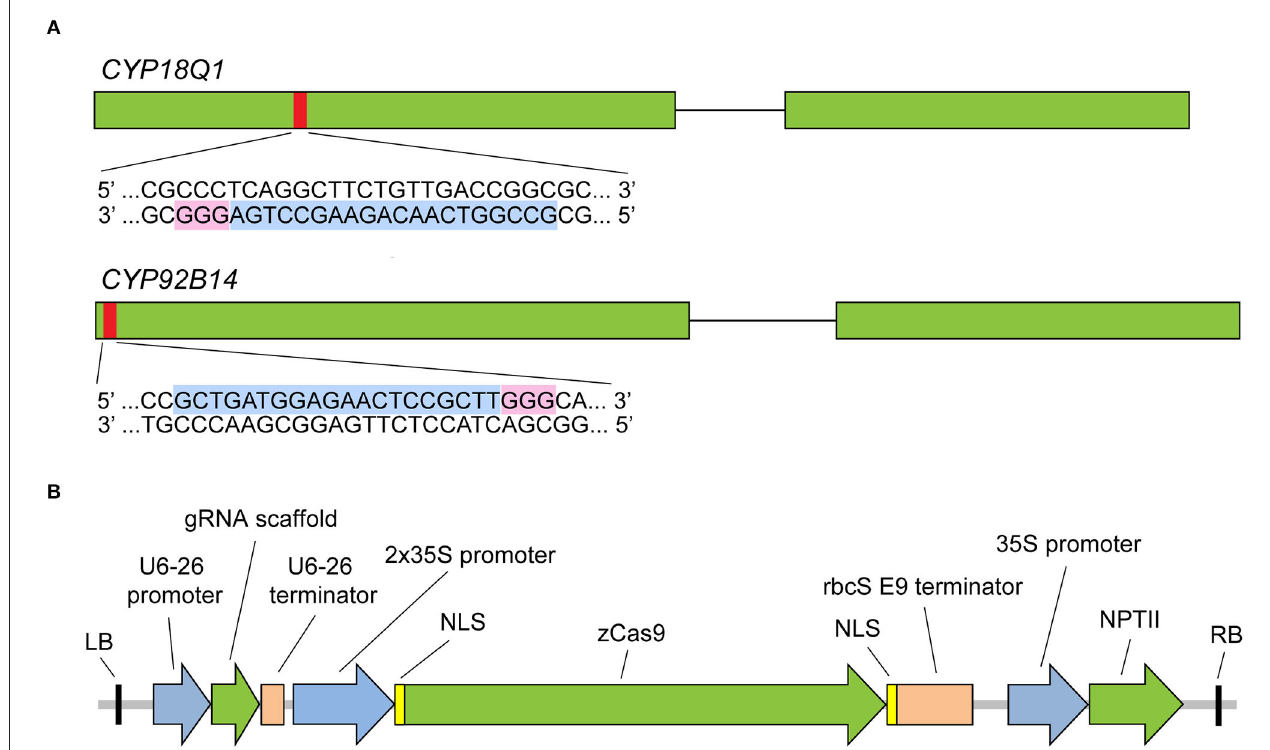
FIGURE 2 | CRISPR/Cas9 sgRNA design and CRISPR/Cas9 binary vector. (A) Diagram illustrating CYP81Q1 and CYP92B14 gene structure and the selected target sequences. Green boxes denote exons, while black lines denote introns. The red boxes denote each gene target site, and sgRNA target sequence and PAM sequences are highlighted in light blue and pink, respectively. (B) The binary vector that was created for the CRISPR/Cas9 system is shown. RB and LB, right and left borders; zCas9 , Zea mays codon-optimized Cas9 ; NLS, nuclear localization sequence; NPTII , neomycin phosphotransferase II gene.